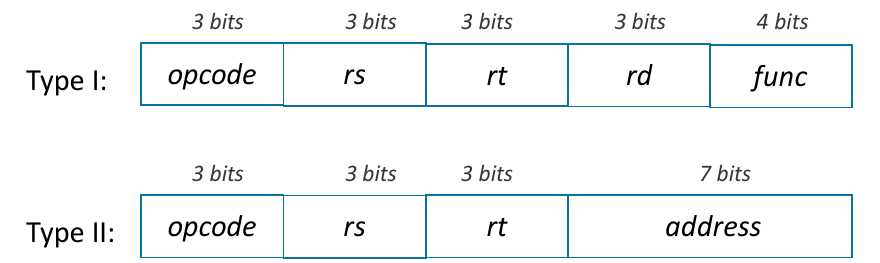
Figure 2. The supported instruction types.